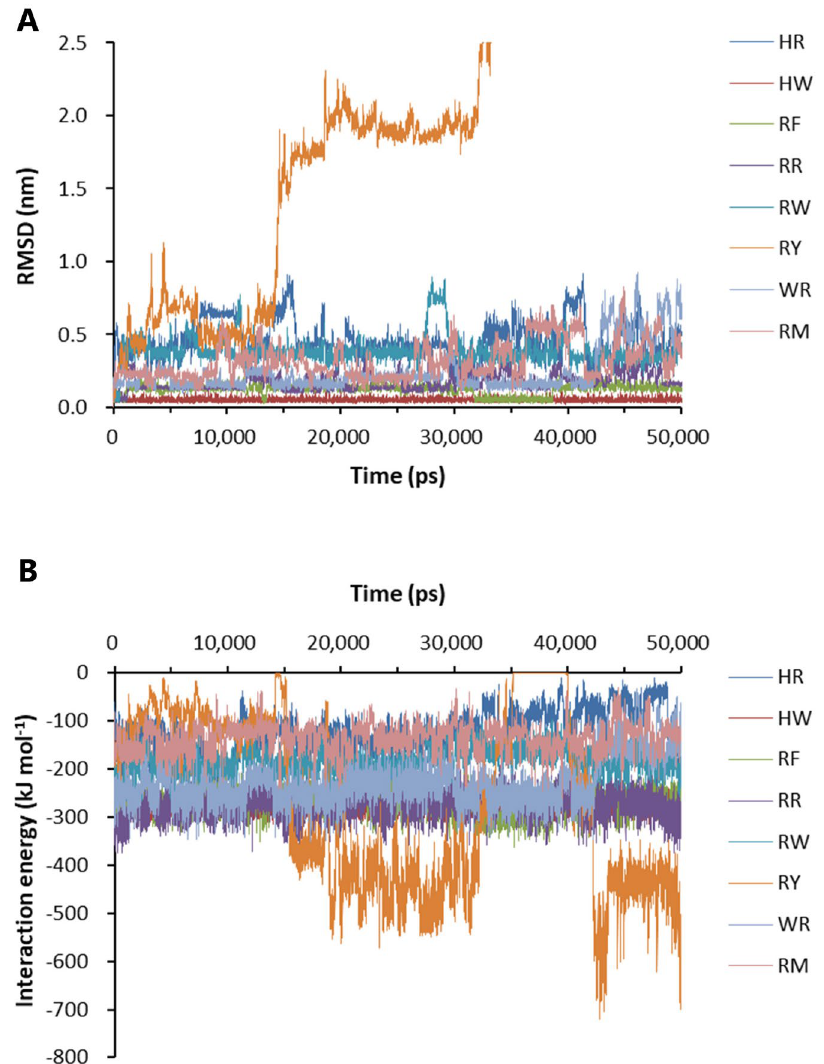
Figure 4. Binding stability and interaction energy of the dipeptides at different binding sites of Aβ 42 pentamer. ( A ) The binding stability of dipeptides to Aβ 42 pentamer. ( B ) The interaction energy between Aβ 42 pentamer and the dipeptides. HR: Histidine–arginine; HW: Histidine–tryptophan; RF: Arginine–phenylalanine; RR: Arginine dipeptide; RW: Arginine–tryptophan; RY: Arginine–tyrosine; WR: Tryptophan–arginine; RM: Arginine–methionine. RMSD: The root-mean-square deviation of the positions of the heavy elements of a dipeptide at different binding sites over time. The